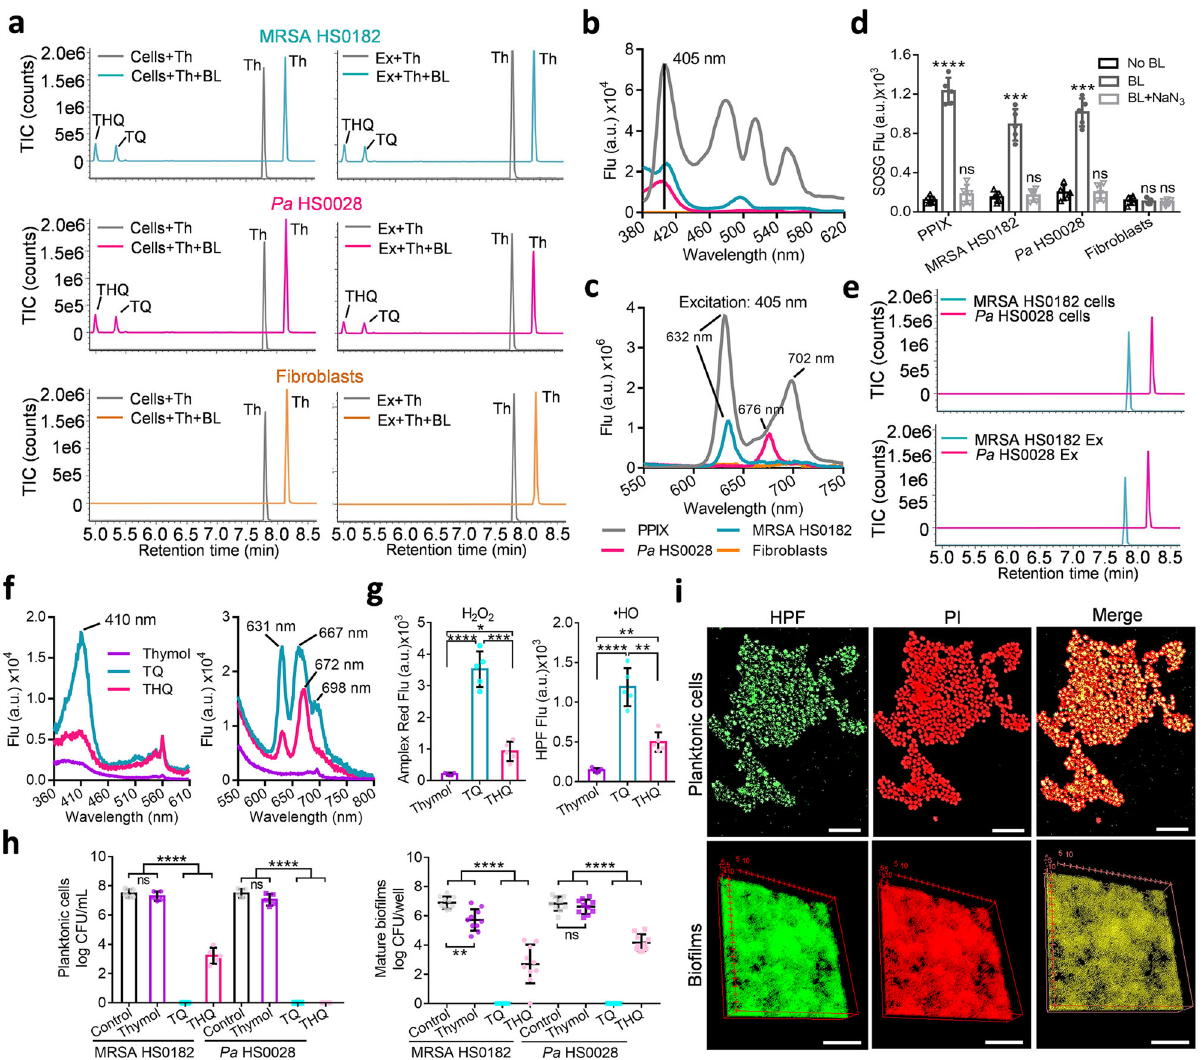
Fig. 6 Photo-oxidation of thymol to generate photosensitizers TQ and THQ exclusively in bacteria. a UPLC-VION-IMS-QTOF-MS/MS analyses of thymol oxidation in cells (left) or extracts (right) of MRSA HS0182 (upper), Pa HS0028 (medium), or fi broblasts (bottom) treated with 0.5 mg/mL thymol in the absence or presence of 50 J/cm 2 BL exposure. b and c Exciation ( b ) and emission ( c ) spectra of an indicated cellular extract in comparison with those of PPIX at 10 µ M. d 1 O 2 is notably generated by 50 J/cm 2 BL in MRSA HS0182, Pa HS0028, and PPIX solution but not in fi broblasts. 1 O 2 generation was blunted by NaN 3 (BL + NaN 3 ), a 1 O 2 -speci fi c quencher. e UPLC-VION-IMS-QTOF-MS/MS analyses of photo-oxidized thymol in the presence of NaN 3 at 10 µ M. BL illumination at 50 J/cm 2 , thymol at 0.5 mg/mL. f Exciation (left) and emission (right) spectra of thymol, TQ, and THQ each at 0.5 mg/mL. g H 2 O 2 and (cid:129) HO were generated by thymol, TQ, and THQ each at 0.2 mg/mL in combination with 50 J/cm 2 BL. h Bactericidal activities of thymol, TQ, and THQ against planktonic cells (left) and established bio fi lms (right) of MRSA HS0182 and Pa HS0028 in the presence of 20 J/cm 2 BL. The concentrations of three compounds were same at 0.05 mg/mL for planktonic cells and 0.1 mg/mL for established bio fi lms. i Representative fl uorescence images of planktonic cells (upper) and established bio fi lms (bottom) of MRSA HS0182 after a lethal dose of the duo treatment. Bacterial viability and intracellular (cid:129) HO were evaluated by PI and HPF staining, respectively. Scale bars: 2 µ m in upper panel and 50 µ m in bottom panel. All images in a , b , c , e , f , and i are representative of fi ve independent experiments. Results in d , g , and h are presented as mean ± SD of at least fi ve independent experiments. **** P < 0.0001; *** P < 0.001; ** P < 0.01; * P < 0.05; and ns, no signi fi